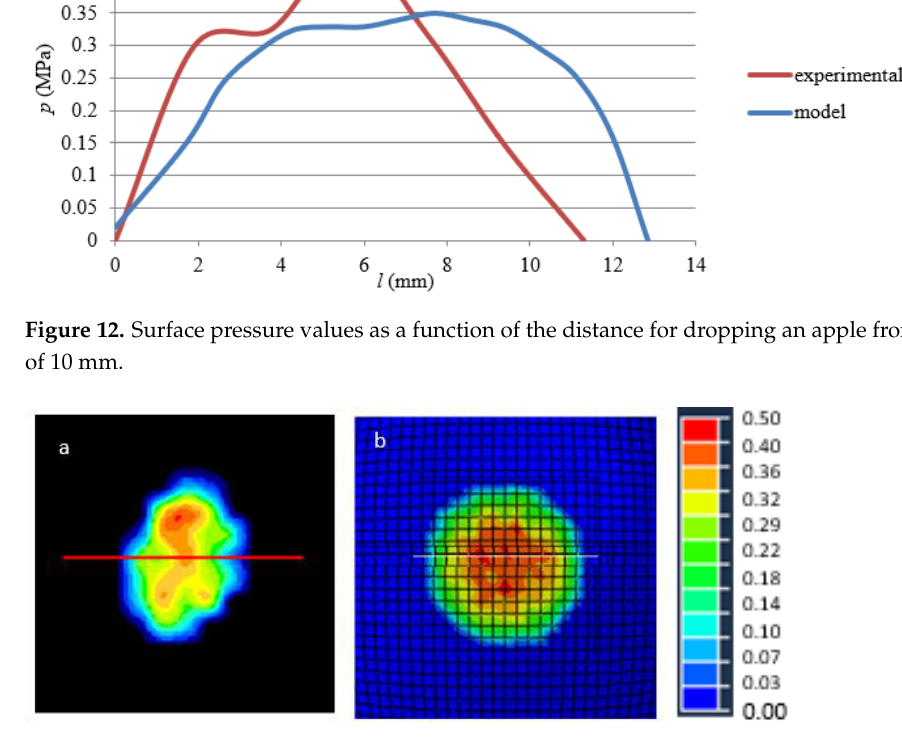
Figure 14. Surface pressure values as a function of distance for dropping an apple from a height of 30 mm on a concrete substrate. Figure 15. Layers and surface pressure distributions of the real object ( a ) and model object ( b ) for an apple dropped from a height of 30 mm on a concrete substrate in a section passing through the central point of contact.